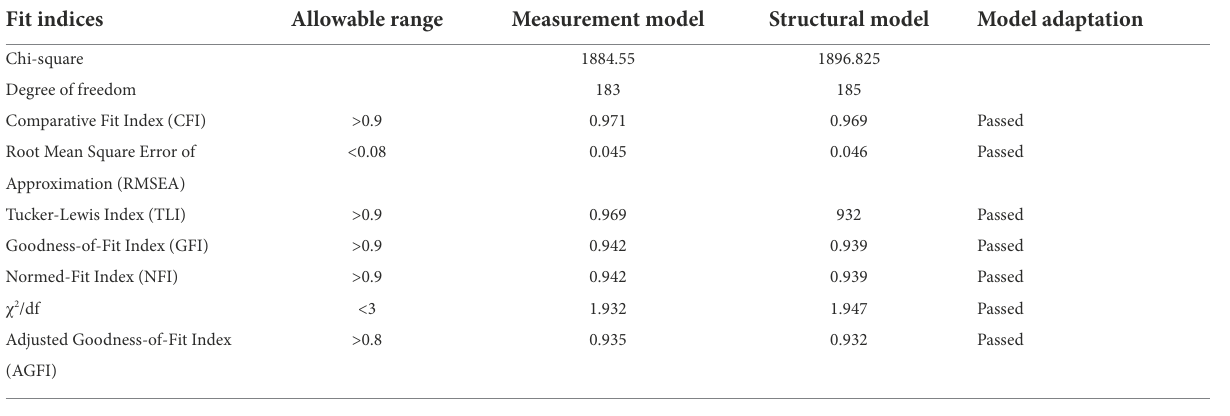
TABLE 5 Model fit criteria and the test results.